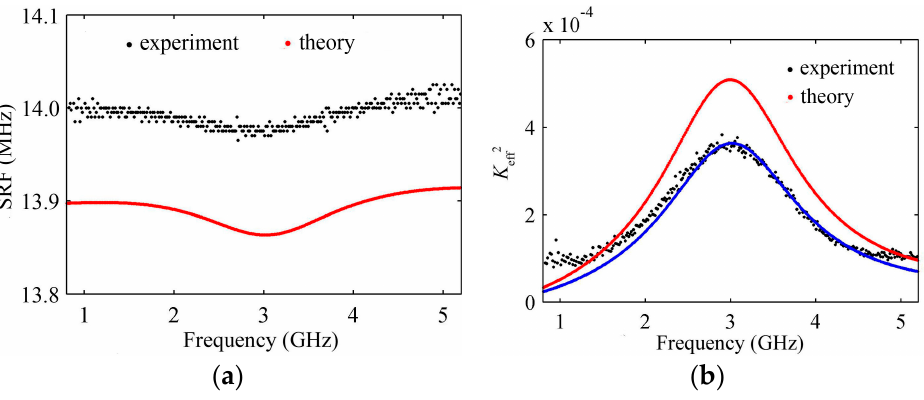
Figure 8. ( a ) The variation curve of SRF with the resonance frequency; ( b ) The variation curve of K eff2 with the resonance frequency.